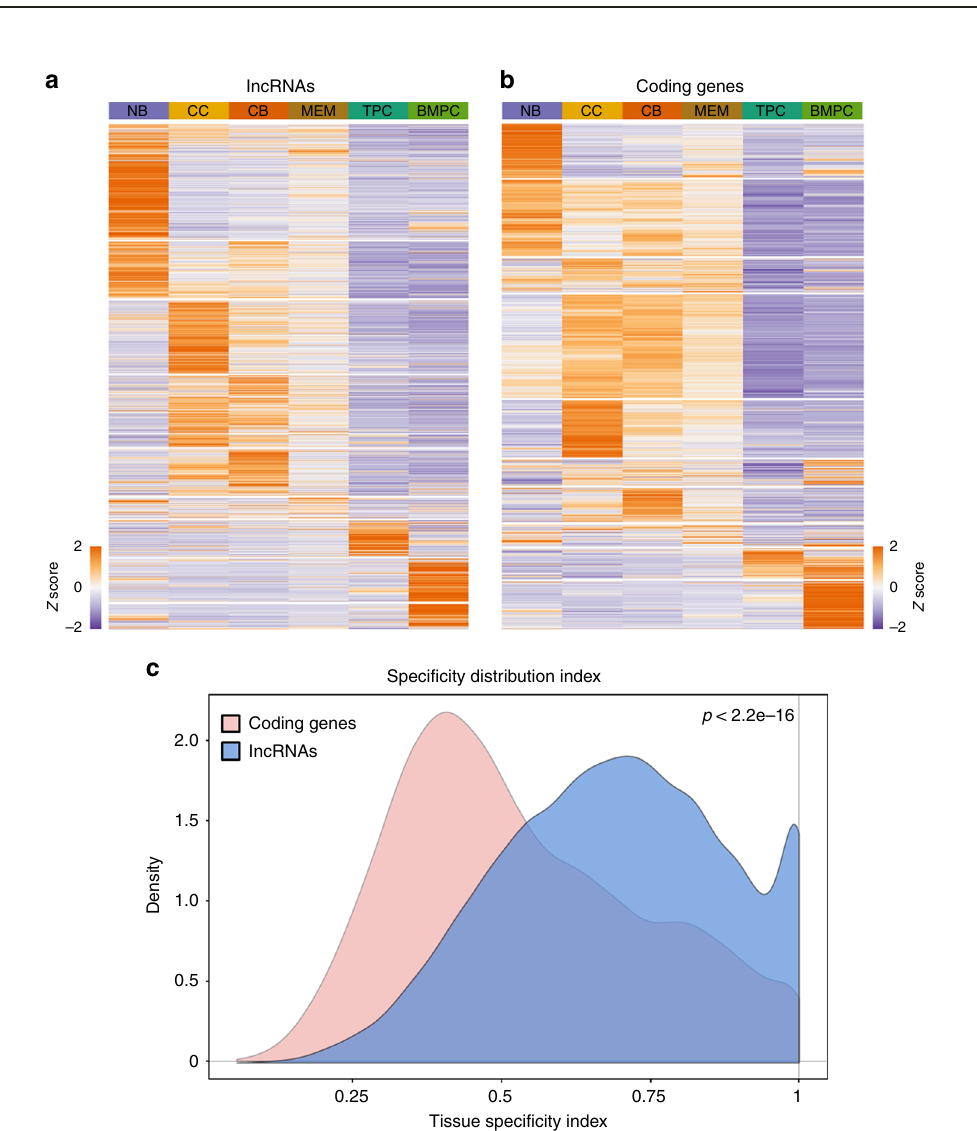
Fig. 3 Speci fi c expressions of long non-coding RNAs (lncRNAs) during human humoral immune response. a Heatmap showing all expressed lncRNAs in B cell subpopulations. b Heatmap showing all expressed protein-coding genes in B cell subpopulations. c Tissue speci fi city distribution index of lncRNAs and protein-coding genes in B cell subtypes ( p < 2.2 × 10 − 16 by Wilcoxon's rank-sum